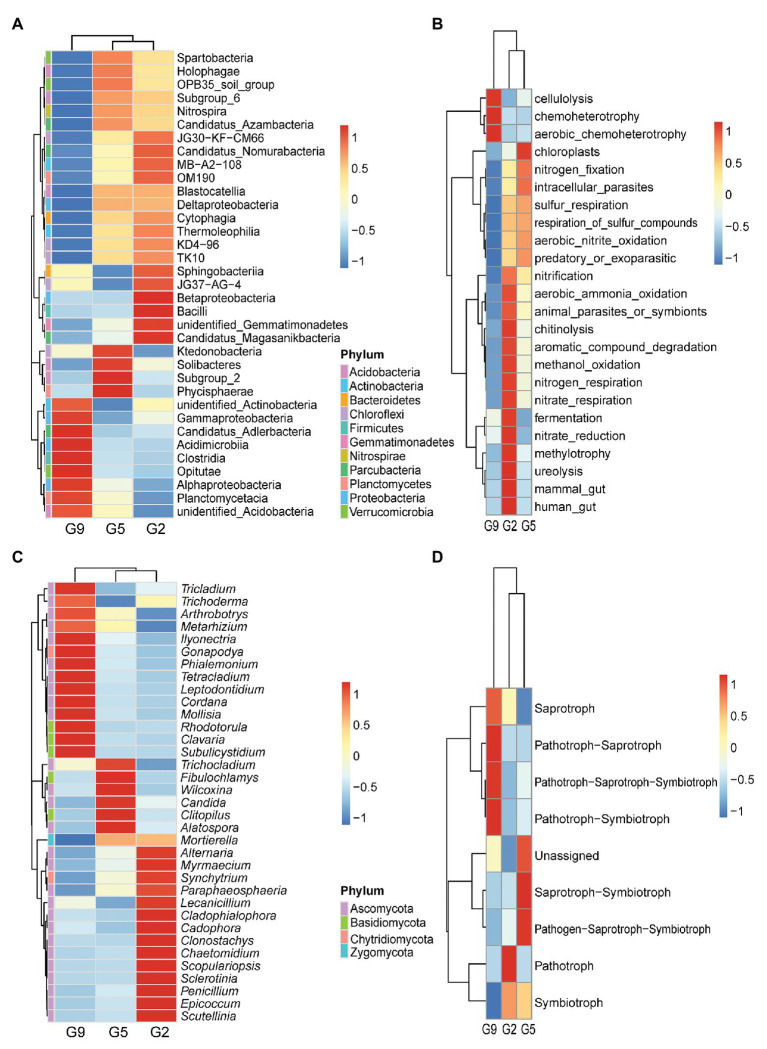
Variations in microbial community compositions and functional characteristics in G2, G5, and G9 soil samples. Heatmap analyses of the abundances of the top 35 bacterial classes (A) and fungal genera (C). Functional analysis was performed using FAPROTAX for bacteria (B) and FUNGuild for fungi (D), respectively.